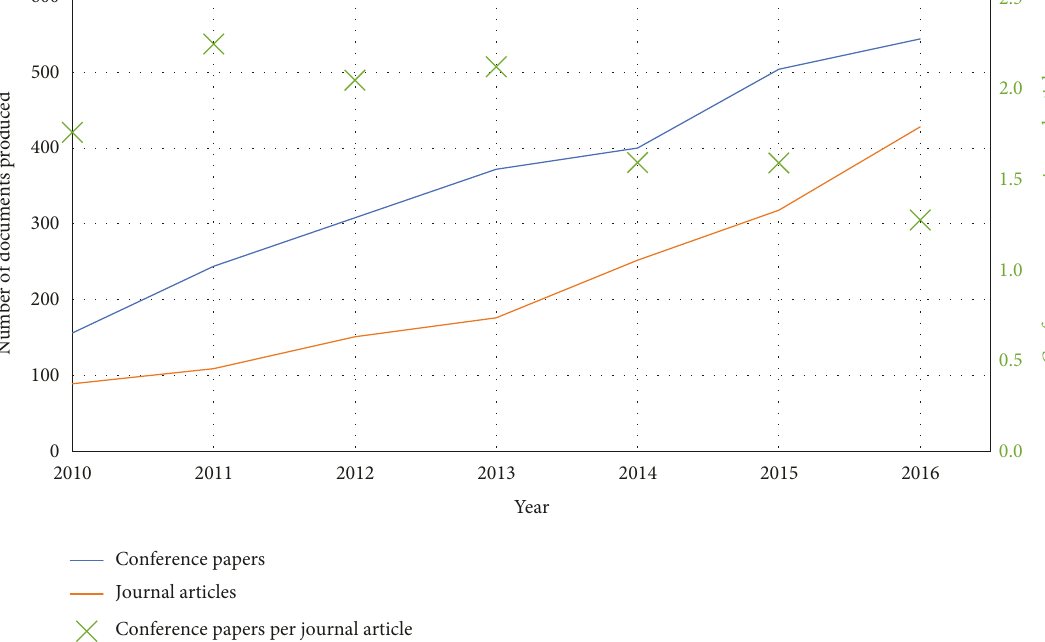
Figure 4: Conference papers and journal articles produced between 2010 and 2016 (primary axis) by search term ( “ energy resource management ” OR “ energy management system ” ) in the SCOPUS